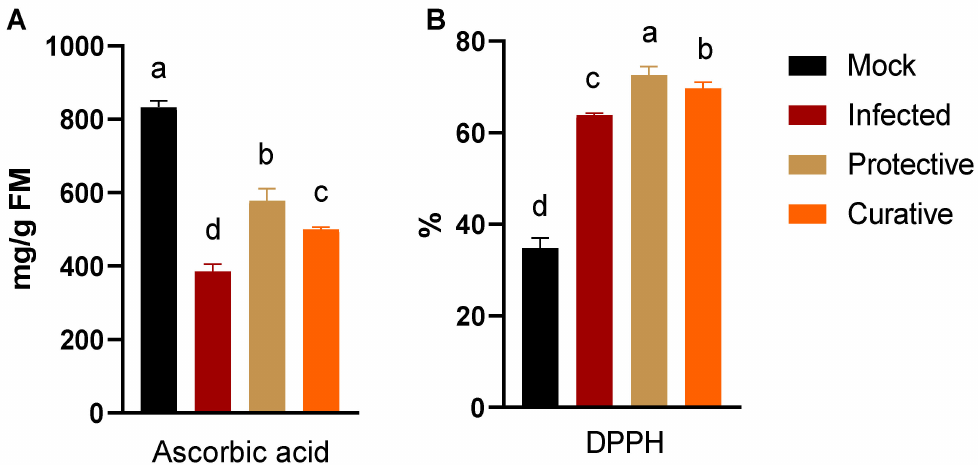
Figure 4. Evaluation of ascorbic acid production titer ( A ) and free radical scavenging activity ( B ) in squash plants. Mock: squash plants foliar sprayed with sterile nutrient broth and mocked with viral inoculation buffer; infected: squash plants mechanically inoculated with ZYMV with foliar spraying of sterile nutrient broth; protective: squash plants sprayed with P. polymyxa strain SZYM-CF 24 h before ZYMV inoculation; curative: squash plants sprayed with SZYM-CF 24 h after ZYMV inoculation. The mean values of each column with the same letter do not differ